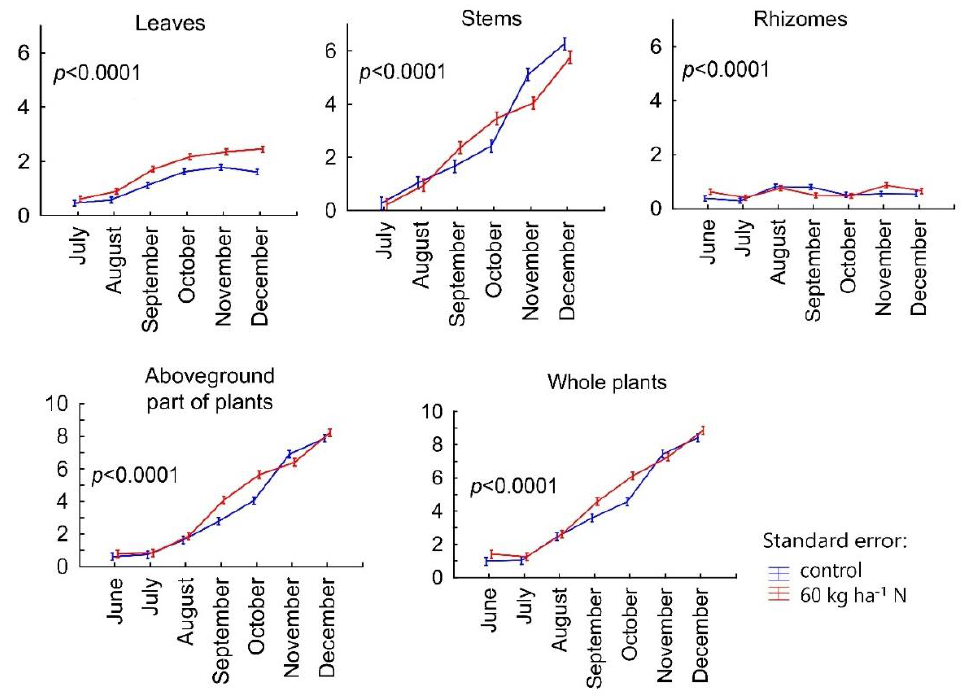
Figure 7. Calcium uptake in examined part of miscanthus (g m −2 ) (three-year average content from measurements during the growing season every 30 days).